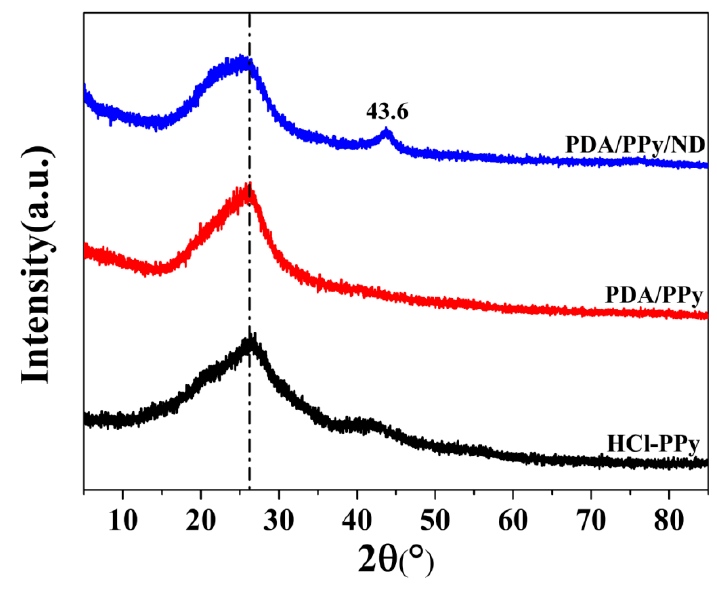
Figure 2. XRD patterns of HCl-Ppy, PDA/Ppy and PDA/Ppy/ND. FTIR spectra were obtained to clarify the hybridization forms in PDA/Ppy/ND and the control samples, as shown in Figure 3a. In the FTIR spectra of HCl-Ppy, bands at 3442 (-OH and -NH stretching vibrations), 1550 (C=C stretching vibration in pyrrole ring), 1447 (C-C stretching vibration in pyrrole ring), 1312 and 1046 (=C-H in plane deformation), 1163 (C-N stretching vibration) and 917 (=C-H out-of-plane deformation) cm − 1 could all be observed, corresponding to the functional groups of Ppy [35,36]. For both PDA/Ppy and PDA/Ppy/ND, the bands attributed to the C-C stretching in pyrrole rings presented obvious blue shifts (to 1457 cm − 1 for PDA/Ppy and 1456 cm − 1 for PDA/Ppy/ND), indi- cating π - π stacking between the benzene ring in PDA and pyrrole rings in Ppy [37]. In addition, the C-N stretching bands at 1163 cm − 1 showed greater blue shifts to 1187 cm − 1 for PDA/Ppy/ND, which may have resulted from the extra asymmetric polar hybridizations among PDA, Ppy and ND involved with the confinement effect of the ND surface [38], making C-N groups more stable. The multiple hybridizations in PDA/Ppy/ND were beneficial for improving dielectric